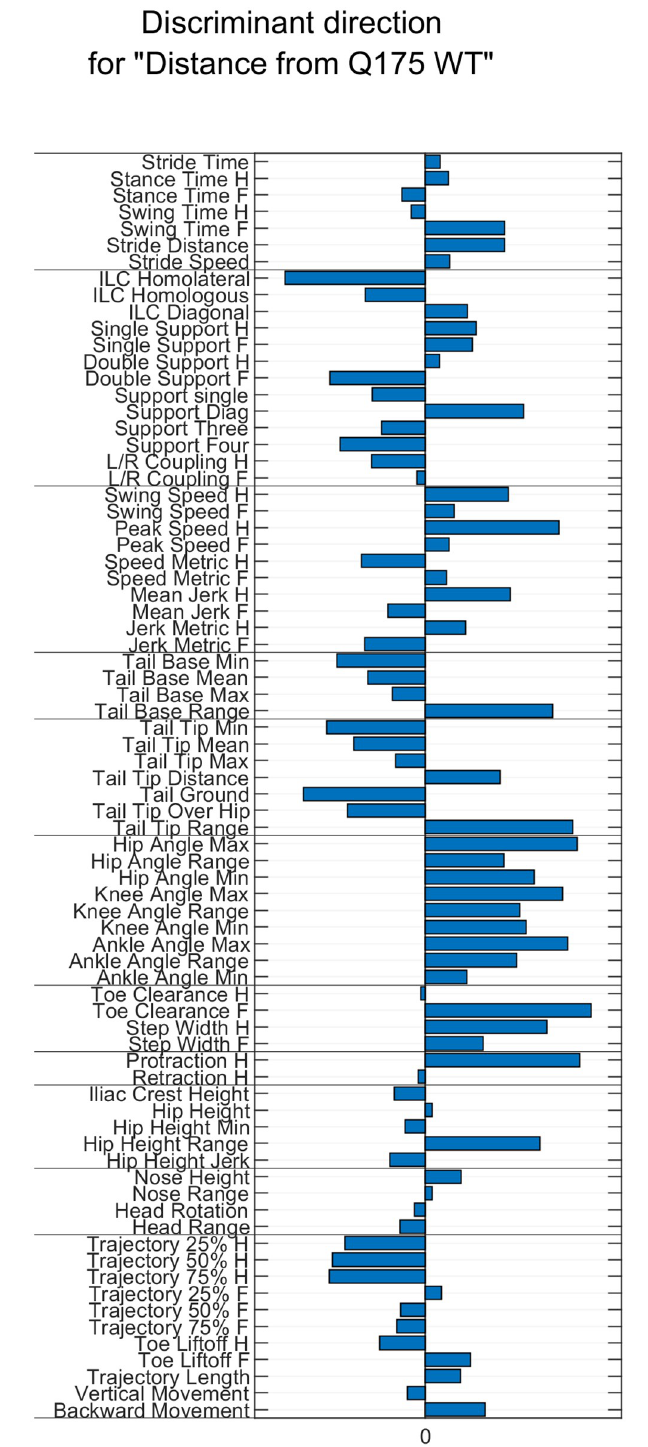
Fig 2. Discriminant vector bar graph of principal component (PC) analysis. The vectors represent unique or enriched features (combination of kinematic variables) in Q175 compared to WT group. In the vector bar graph, the bar length and direction correspond to the weight of individual parameters in the corresponding PC.